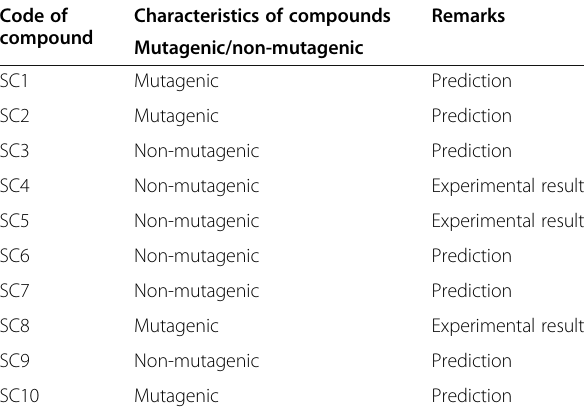
Table 7 Mutagenic property of compounds of fermented Syzygium cumini seed methanolic extract Code of compound